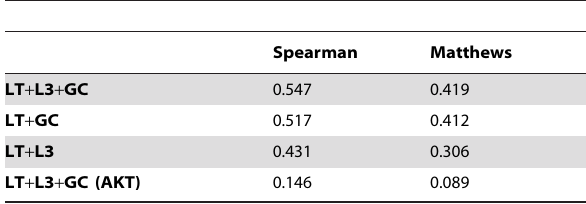
Table 3. The support vector machine shows high correlation for combinations of total length with 3 9 UTR length and/or G + C content.